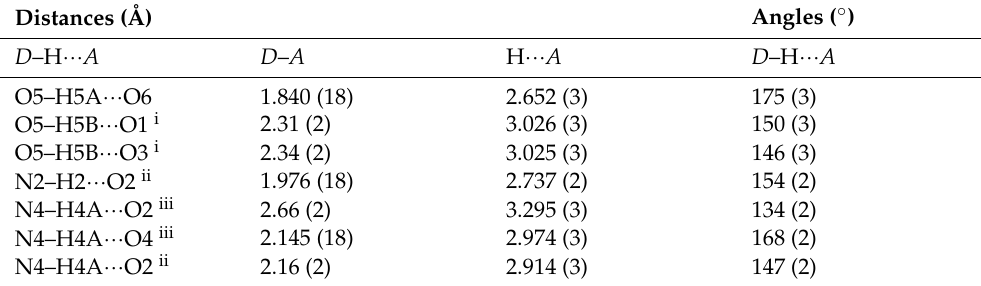
Table 3. Hydrogen bonding geometry parameters for Complex 2